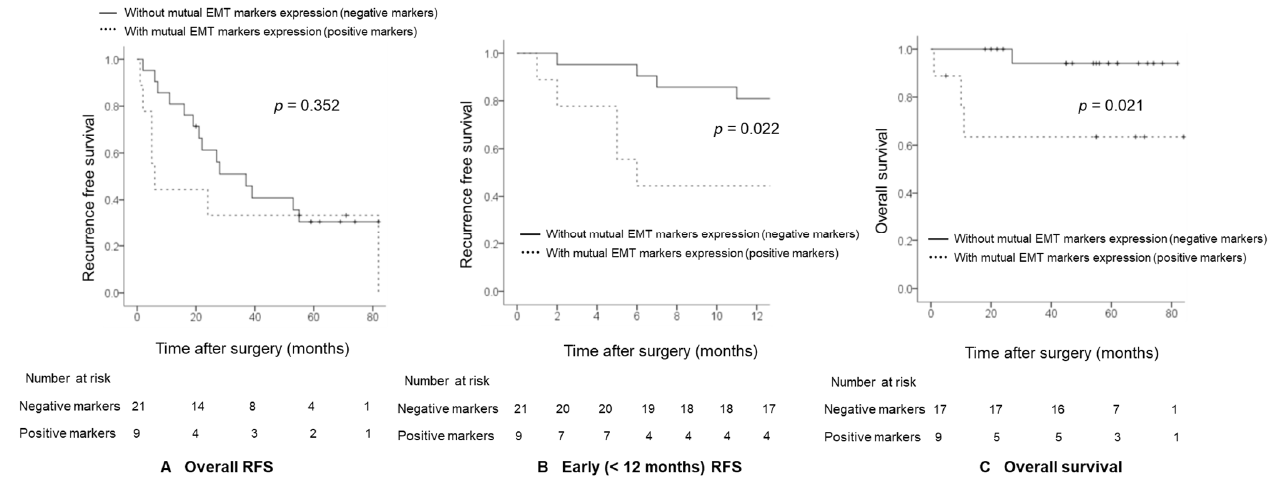
Figure 2. Kaplan–Meier curves for overall ( A ), early (<12 months) RFS ( B ), and overall survival ( C ) in HCC patients according to combined EMT markers expression. EMT, epithelial–mesenchymal transition; HCC, hepatocellular carcinoma; RFS, recurrence-free survival.